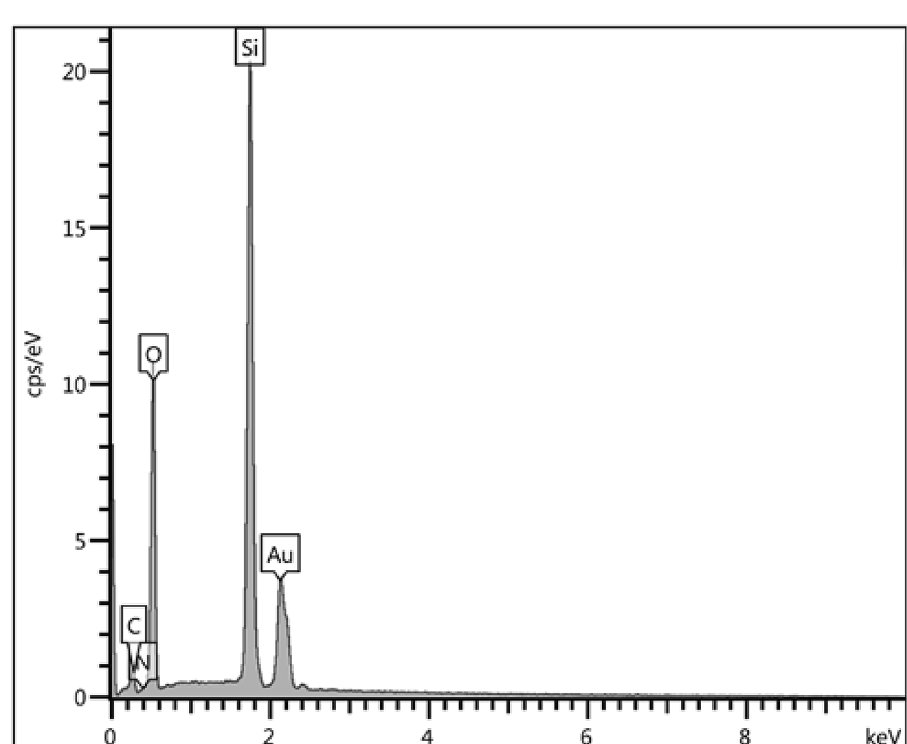
Figure 5. EDX spectrum of the KIT-5-biguanidine-Au (0)